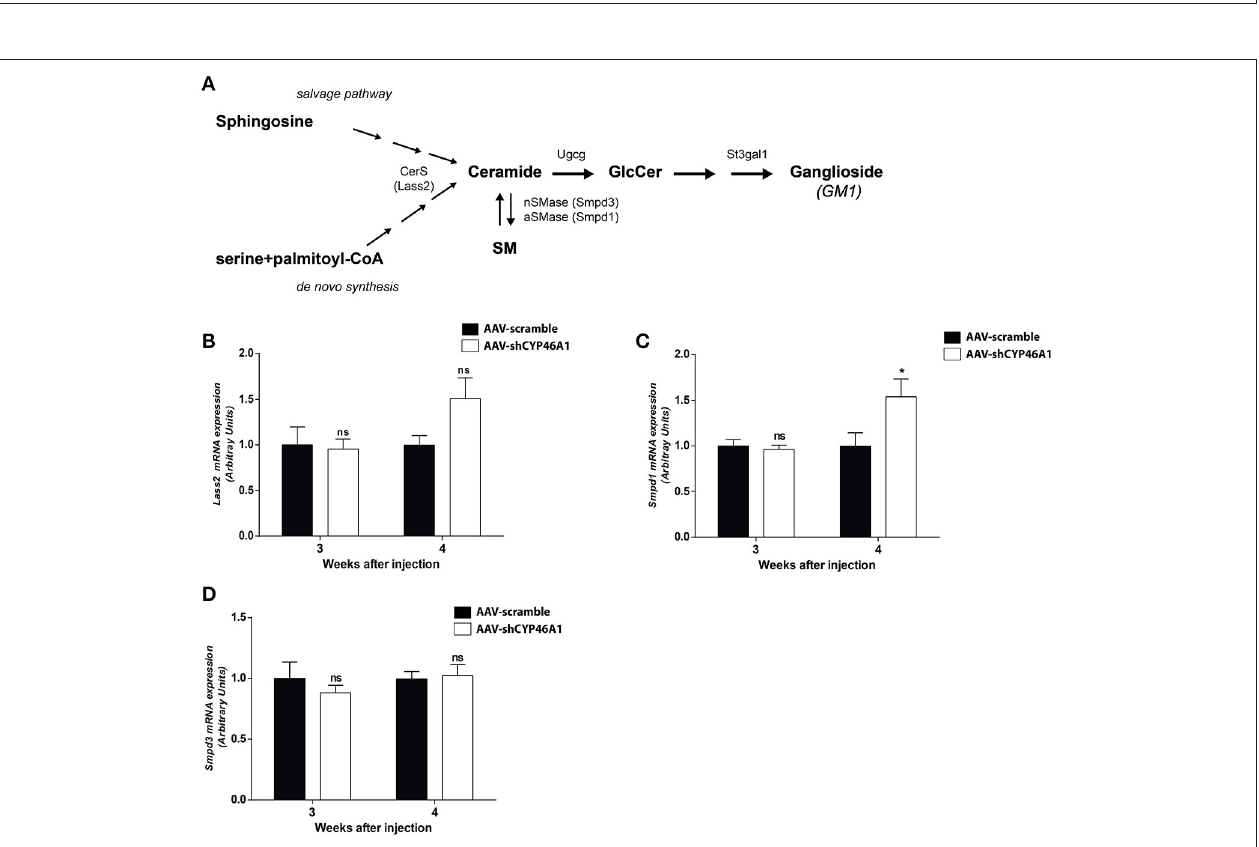
FIGURE 5 | Sphingolipid metabolism (A) . Quantitative expression of ceramide synthase 2 (LASS2) (B) , acid sphingomyelinase (SMPD1) (C) and neutral sphingomyelinase (SMPD3) (D) genes in C57BL/6 mice after cerebral injections of AAV-scramble and AAV-shCYP46A1 vectors. Quantitative expression of murine Lass2 (B), Smpd1 (C) and Smpd3 (D) genes were performed 3 and 4 weeks post-injection ( n = 5 mice). Expression data are normalized to the expression of AAV5-scramble (control). Unpaired t -test was performed. * P < 0.05; ns, non-significant.